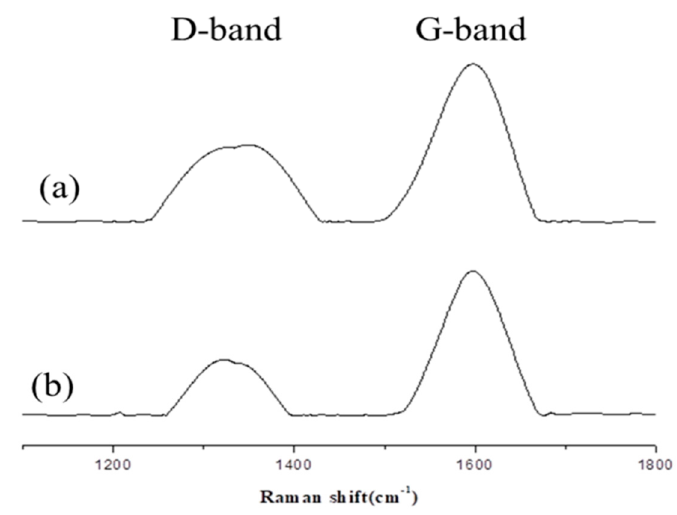
Figure 11. The Raman spectra of char products from PU/HBNPSi 40% at 800 °C ( a ) 1 min and ( b ) 5 min. Table 3. The area ratio of Raman shift from PU/HBNPSi hybrid char.